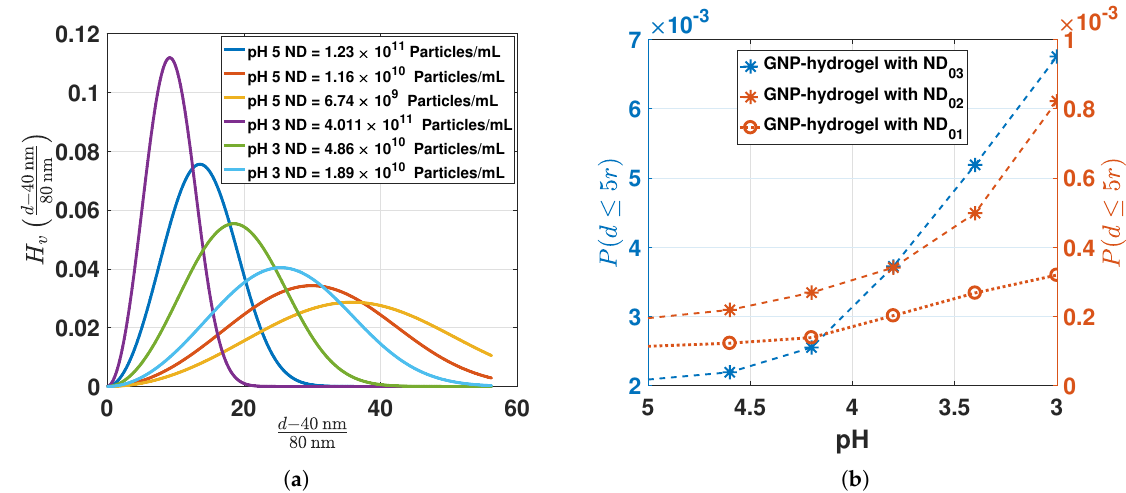
Figure 6. ( a ) Computation of the void nearest-neighbor distribution function (NNDF) (Equation (11)) for the NDs estimated in Figure 5 for pH 5 and 3; ( b ) computed probability (Equation (12)) for the interparticle distances between 2 r ≤ d ≤ 5 r from the ND estimated in Figure 5.